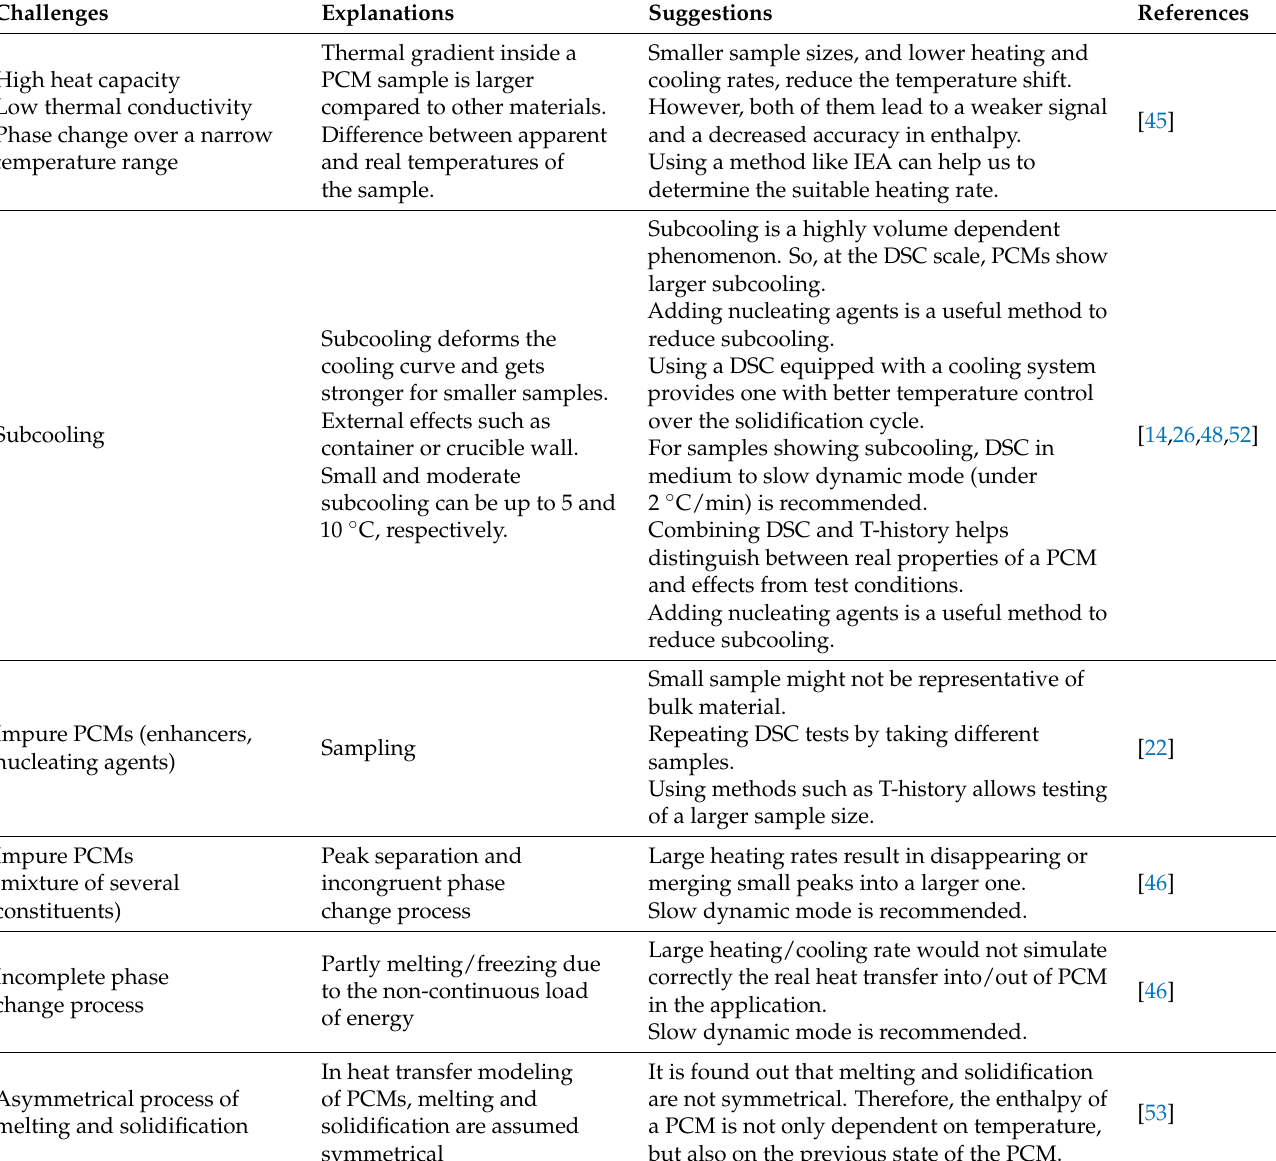
Table 5. Challenges in calorimetry measurements of